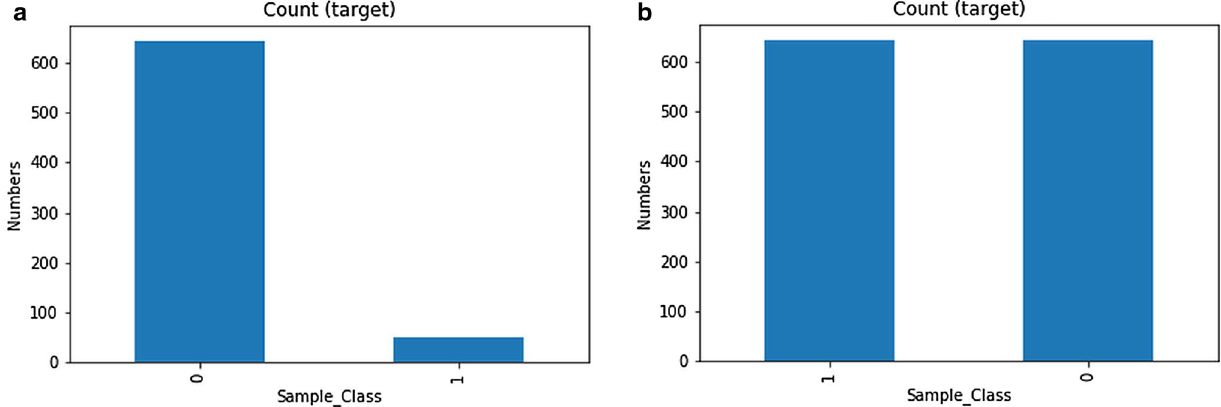
Figure 5. CRC Dataset classes. ( a ) dataset before balancing the classes, and ( b ) dataset after oversampling to achieve class balance. 0—Tumor,